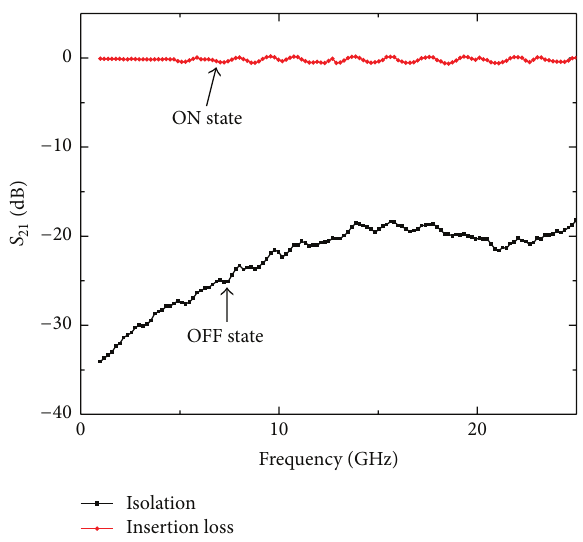
Figure 7: Measured 𝑆 -parameter response of the SPDT